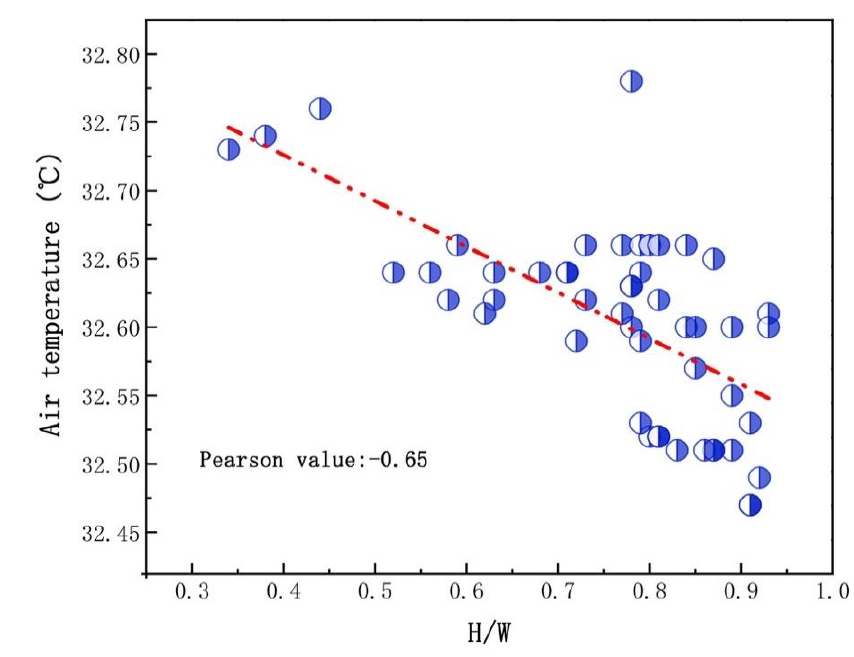
Figure 8. Scatterplot of H/W (the ratio of height and road width) and AT (air temperature) at 13:00 on a hot summer day (21 July 2018).